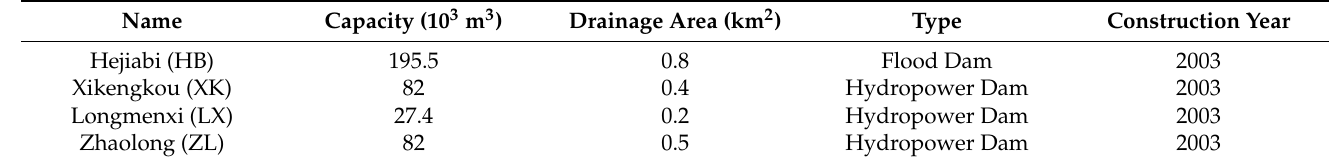
Table 1. Small dam information in the L–S Creek watershed